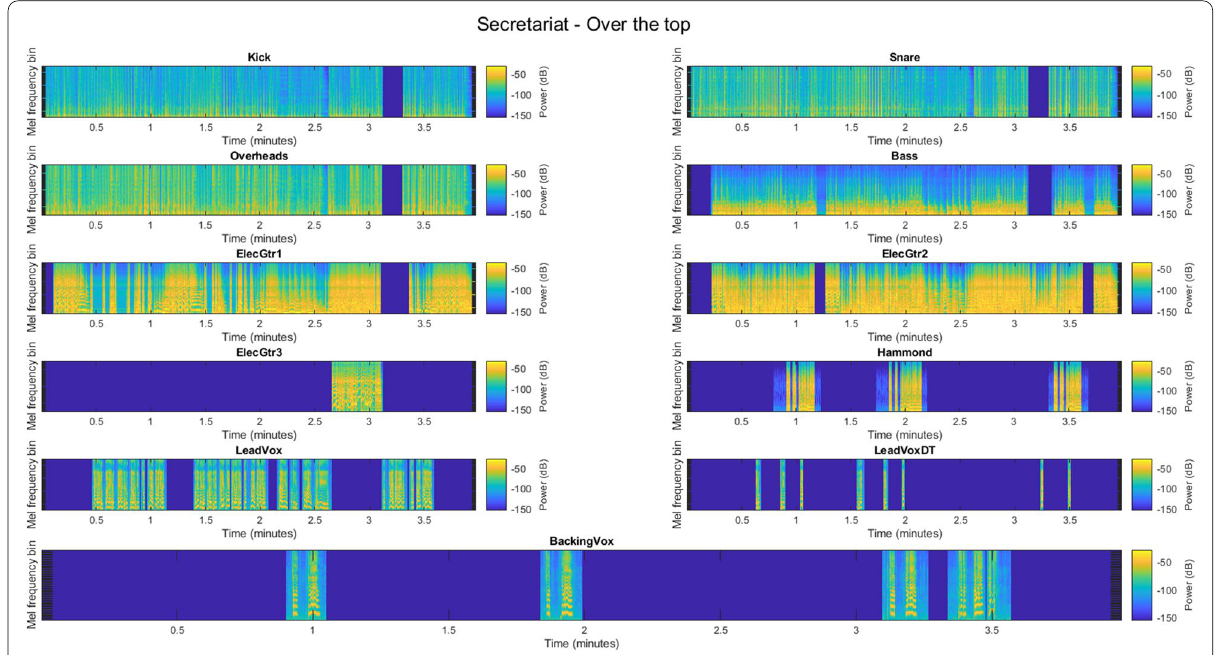
Fig. 3 All 11 tracks from “Secretariat—Over the top” song in the form of mel spectrogram